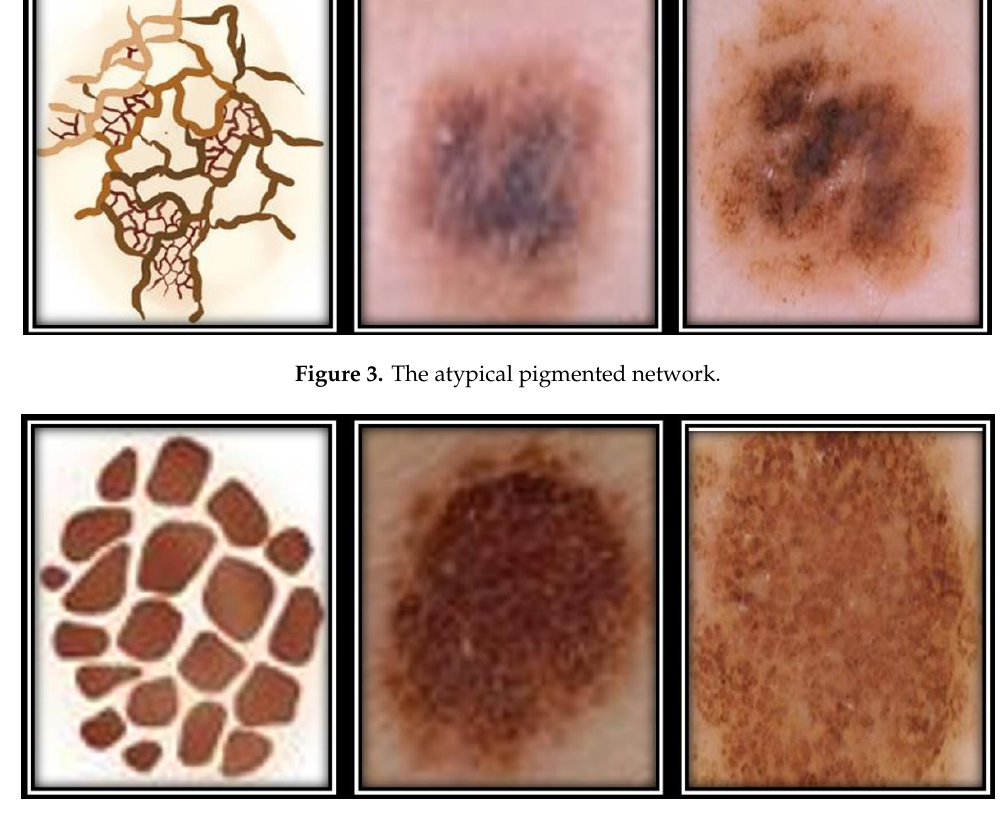
Figure 4. The globule dermoscopic structures.